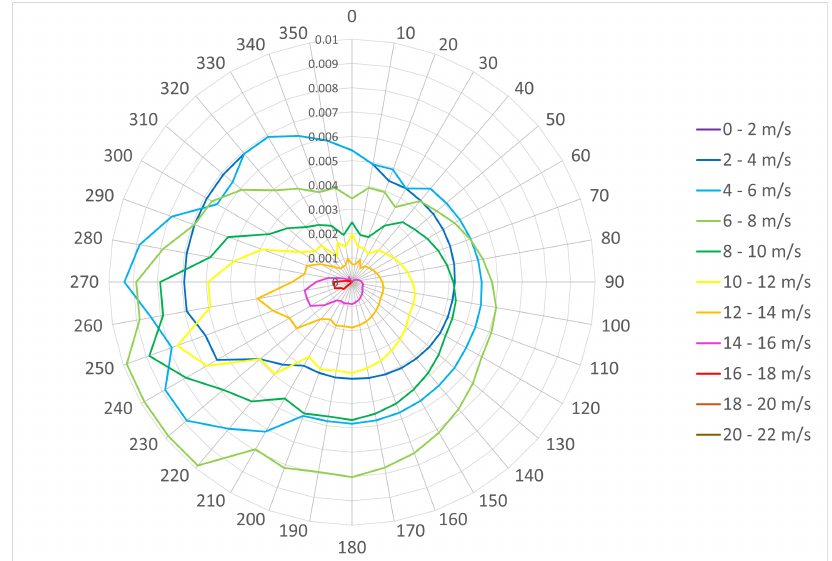
Figure A7. Wind Rose C – with prevailing wind